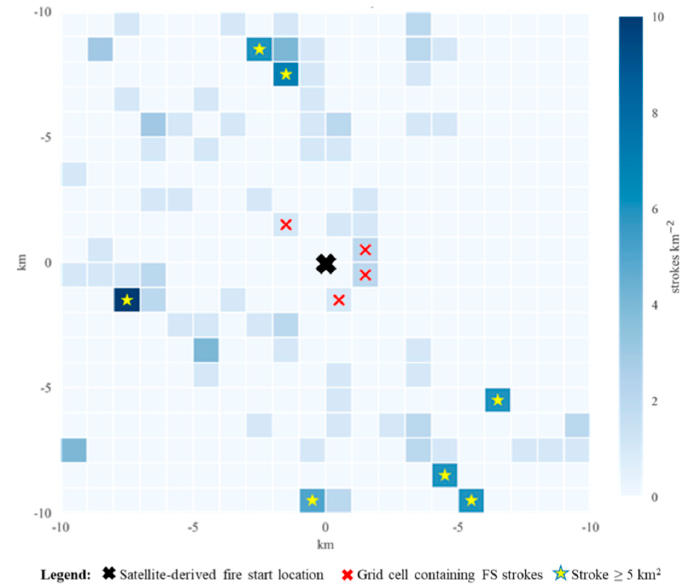
Figure 8. Stroke densities (strokes km − 2 ) within the 20 km by 20 km domain centered on the fire start location of the Parker 2 Fire from 0010 UTC 25 July 2017 through 0256 UTC 25 July 2017. The square boxes represent 1 km 2 grid cells with their stroke densities shaded accordingly.